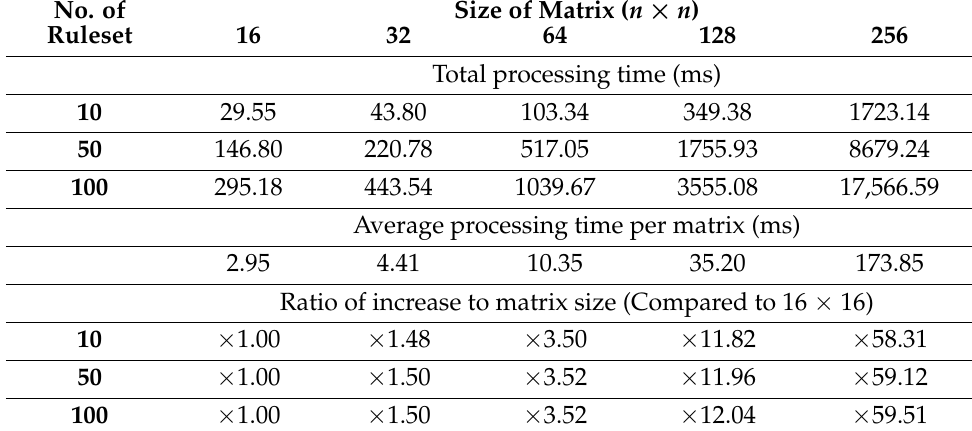
Table 1. Performance evaluation of proposed methodology.